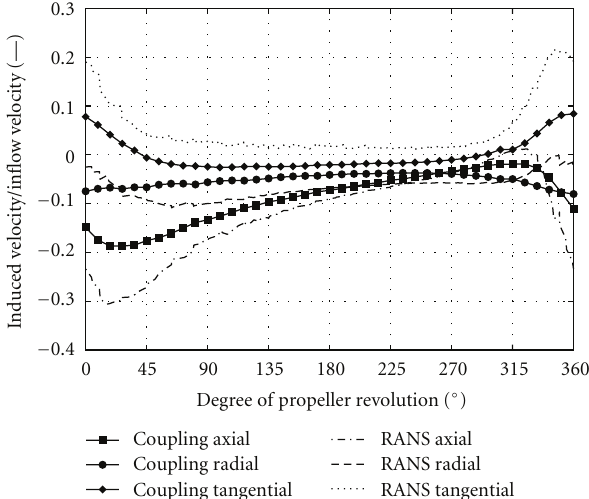
Figure 12: Comparison between the normalised induced velocities obtained from a coupled (explicit mode) and a RANS simulation with a geometrically modeled propeller ( r/R = 0 . 7, J = 0 . 5, dt · n = 3 . 78 ◦ , and dx = 0 . 5 R